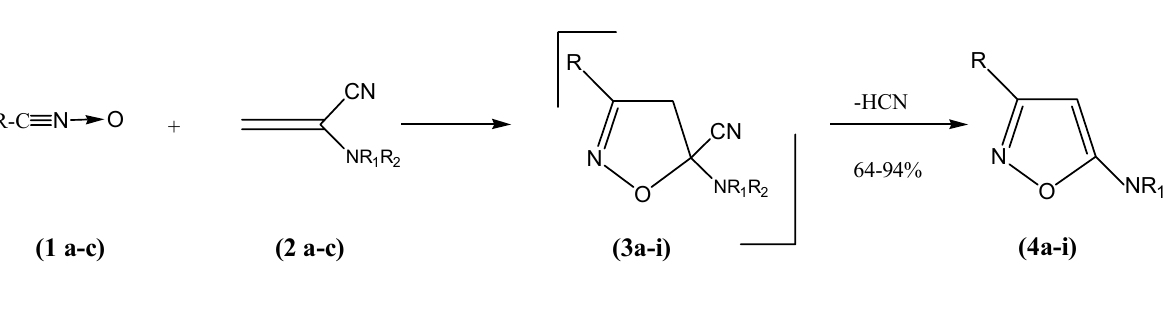
Scheme 1 : Synthesis of 5-aminoisoxazoles 4a-i